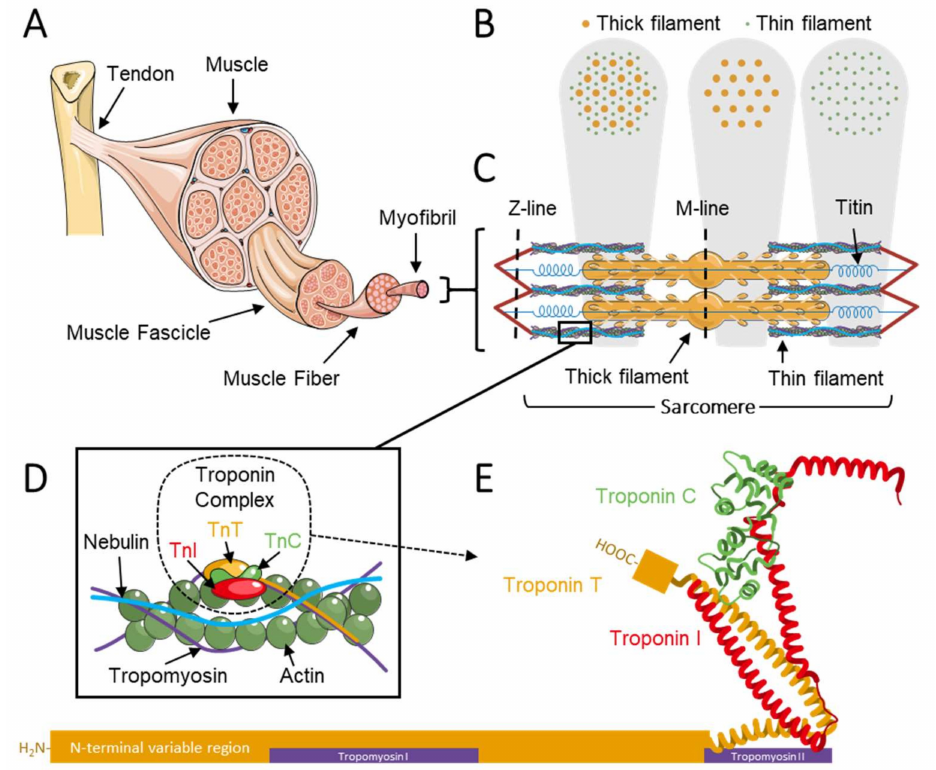
Figure 1. Schematic showing muscle structure at different levels of organization. ( A ) Whole mus- cle. ( B ) The thick and thin filaments are spaced in a symmetrical lattice. Every thick filament is surrounded by 6 thin filaments. The left panel shows a region of thick and thin filament overlap, the middle panel shows the H zone (including the thick filament and excluding the thin filament), and the right panel shows the I band (including the thin filament and excluding the thick filament). ( C ) The sarcomere. The grey shading indicates the corresponding lattice structure shown in ( B ). ( D ) The thin filament, including actin, nebulin, tropomyosin, and the troponin complex (troponin I, T, and C) ( E ) The troponin complex. Images A, C and D are modified from Servier Medical